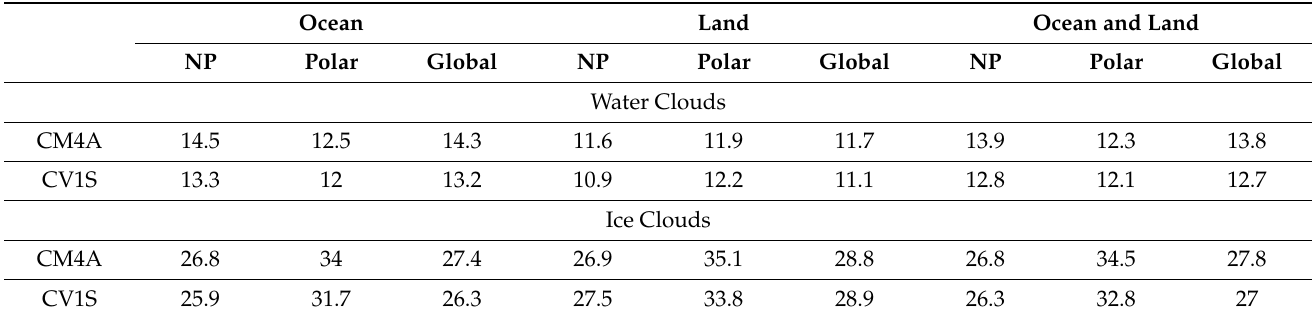
Table 6. Same as Table 2, except for the daytime mean cloud droplet and ice crystal effective radii ( µ m).